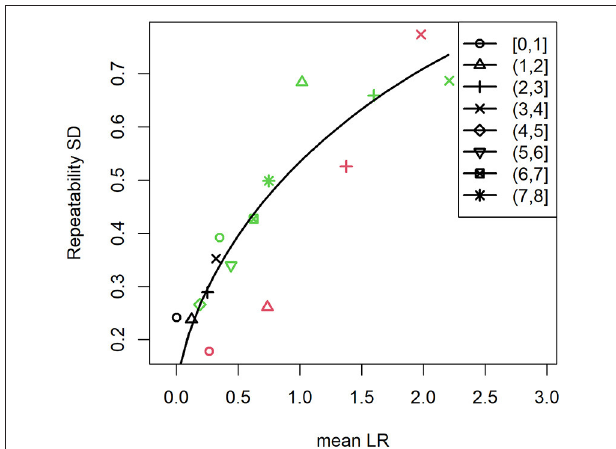
FIGURE 4 | Repeatability standard deviation increases with the observed log reduction. Symbol shapes correspond to the observation time period (h) while colors indicate the concentration of PMNs that were used to challenge S. aureus . Black symbols indicate low PMN concentration ( Figure 3A ), red symbols indicate medium PMN concentration ( Figure 3B ), and green symbols indicate high PMN concentration ( Figures 3C,D ). Solid line represents the quadratic trend in the repeatability variance. Brackets indicate that the value is included in the given time range while parentheses indicate that the value is